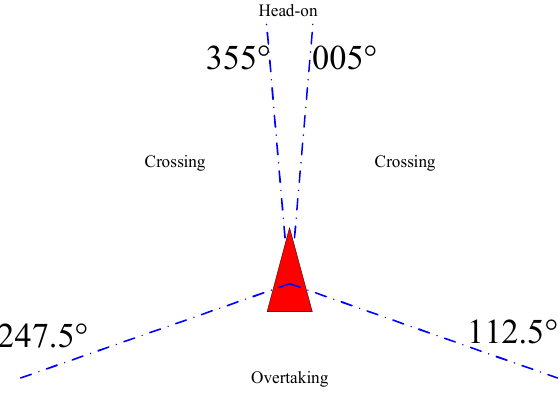
Figure 3. Collision avoidance steering diagram based on the International Regulations for Preventing Collisions at Sea (COLREGS).